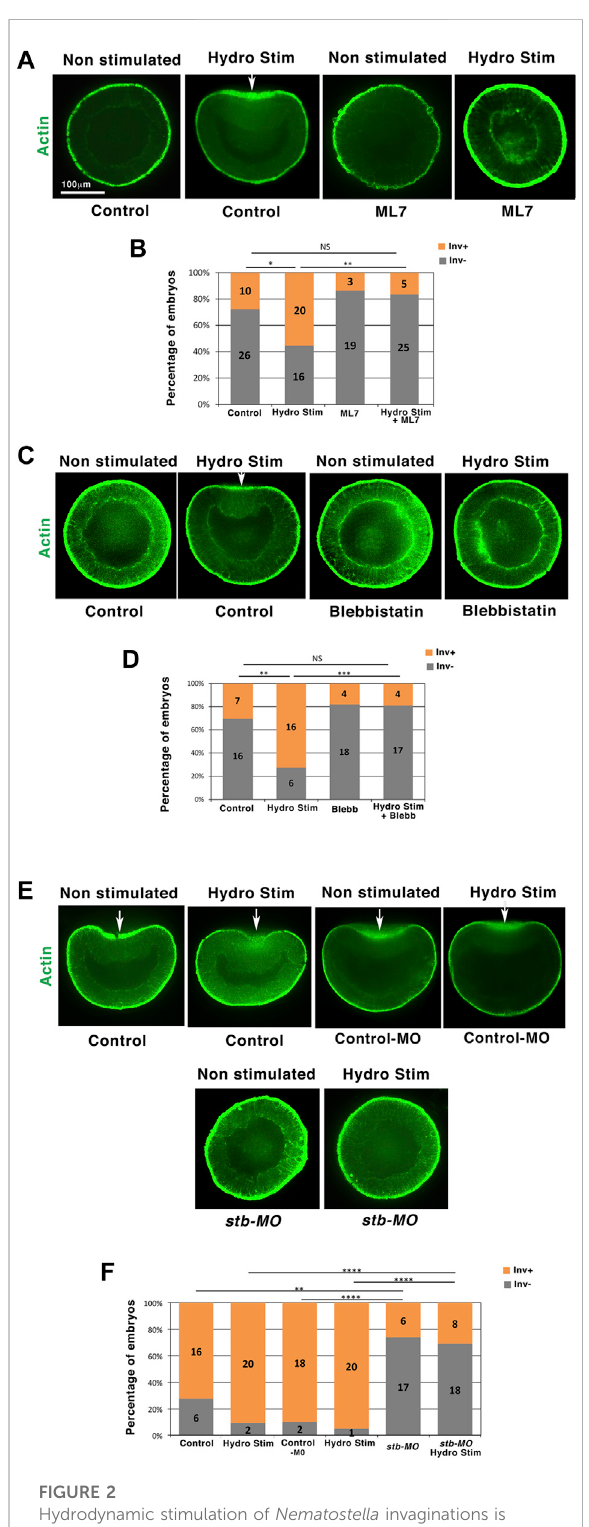
FIGURE 2 Hydrodynamic stimulation of Nematostella invaginations is Myo-IIand stb dependent. (A) 18 hhydrodynamicallystimulated N. vectensis embryos in the presence of the ML7 MLCK of Myo-II inhibitor. Control: ethanol, vehicle of ML7 (see methods). ML7-treated embryos show a slightly higher thickness